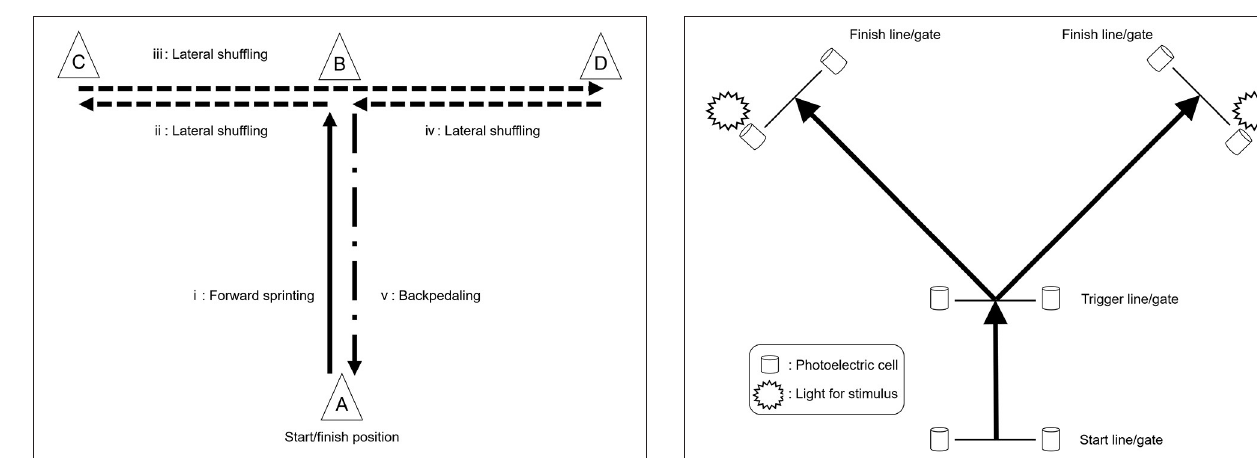
FIGURE 2 | The typical protocol of a reactive test. This test requires decision-making in response to external stimuli before subjects change their direction. They run forward from the start line/gate to the trigger line/gate, at which point the light at the finish line/gate on either the right or left illuminates. The subjects must cut and sprint to the right or left finish line/gate depending on which light is illuminated. The performance is evaluated by the whole time (start-finish) and the time after the stimuli